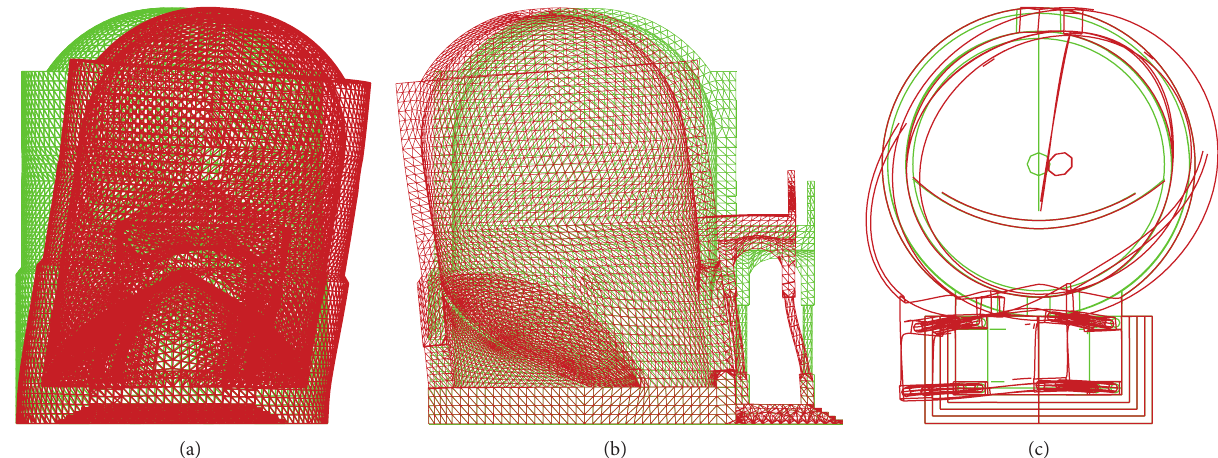
Figure 13: Chapel XVII mode 1 of vibration (a); Chapel XVII mode 2 of vibration (b); Chapel XVII mode 3 of vibration (c).